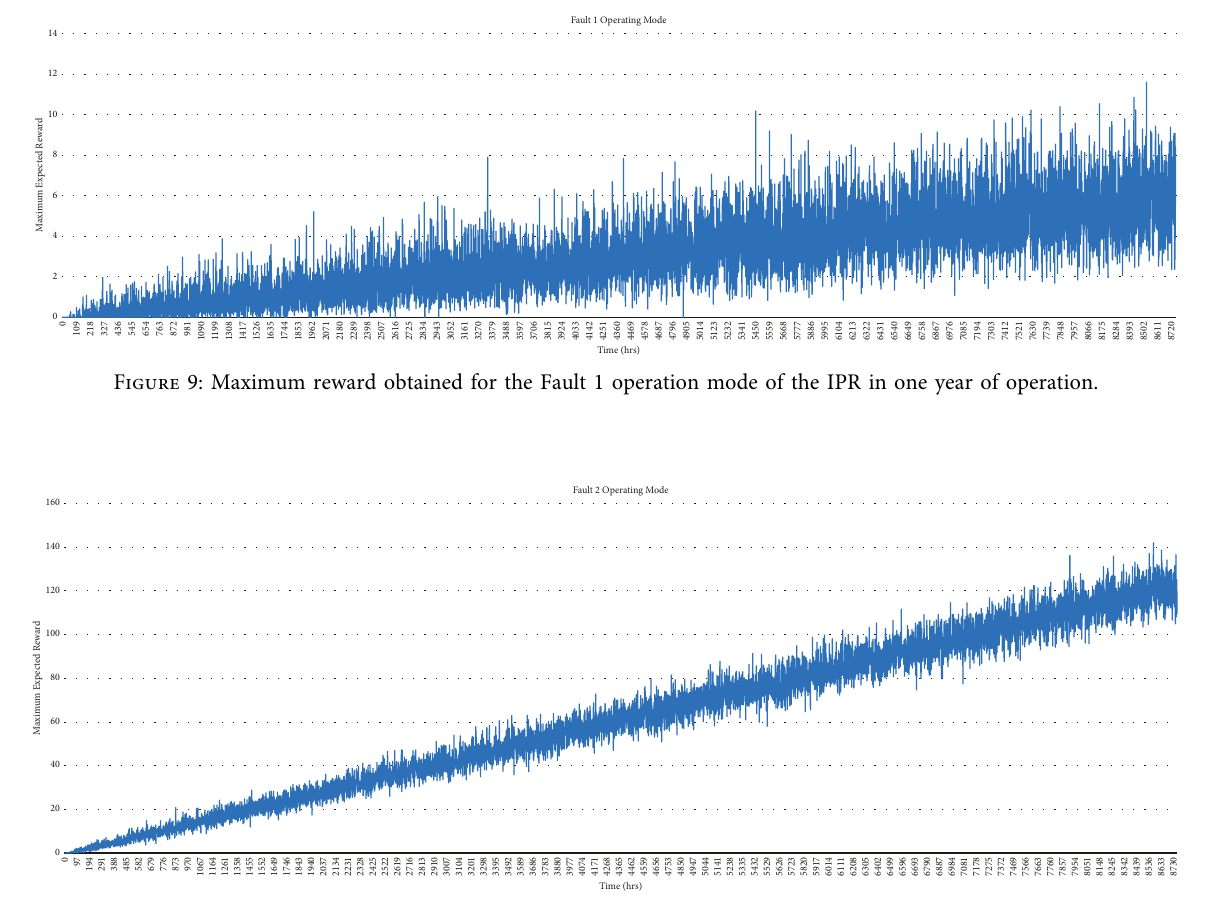
Figure 10: Maximum reward obtained for the Fault 2 operation mode of the IPR in one year of operation.